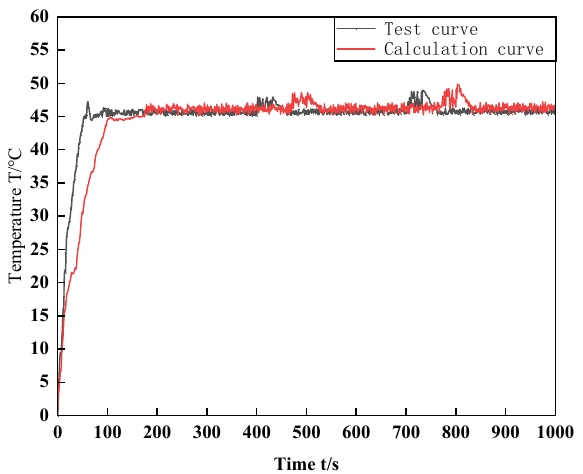
Figure 7. Comparison of the test and calculated temperatures of the MR fluid under 300 rpm.